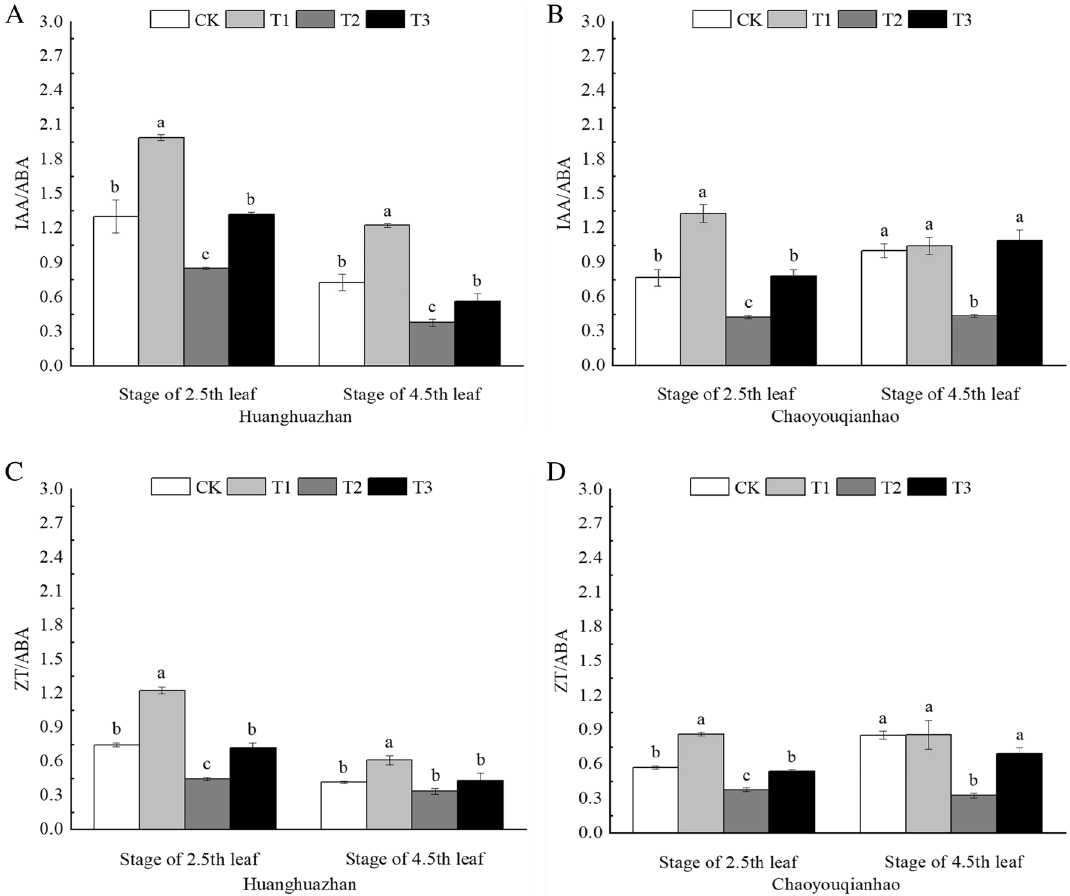
Figure 11. Effects of soaking with BR on hormone homeostasis of rice seedlings under salt stress. Different lowercase letters indicate significant differences at the P < 0.05 level. CK: soaking with distilled water + watering 0 g L −1 NaCl. T1: soaking with BR + watering 0 g L −1 NaCl. T2: soaking with distilled water + watering 3 g L −1 NaCl. T3: soaking with BR + watering 3 g L −1